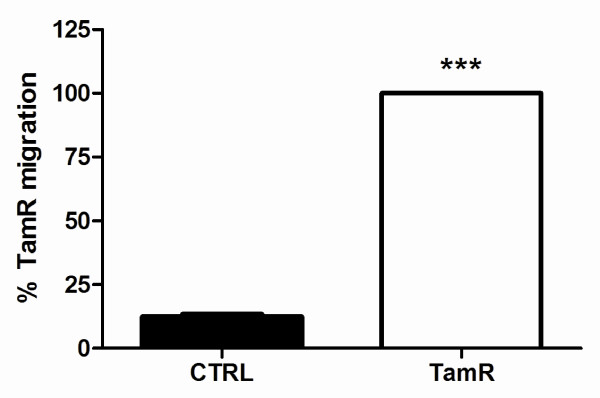
Acquired resistance to tamoxifen in MCF-7 cells leads to enhanced migration capacity. 2.5 × 104 MCF-7 or MCF-7-TamR cells were seeded on the upper chamber of a transwell system where the lower wells contained media with 5% serum. After 24 h, cells were fixed and stained with crystal violet and the number of migrated cells counted. Bars represent the percent of migrated MCF-TamR cells per 100 × field of view ± SEM. ***, P < 0.001.